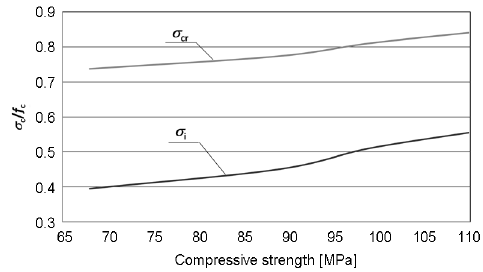
Fig. 10. Levels of cracking initiating stress σ i and critical stress σ cr in high-performance concretes under compression versus compressive